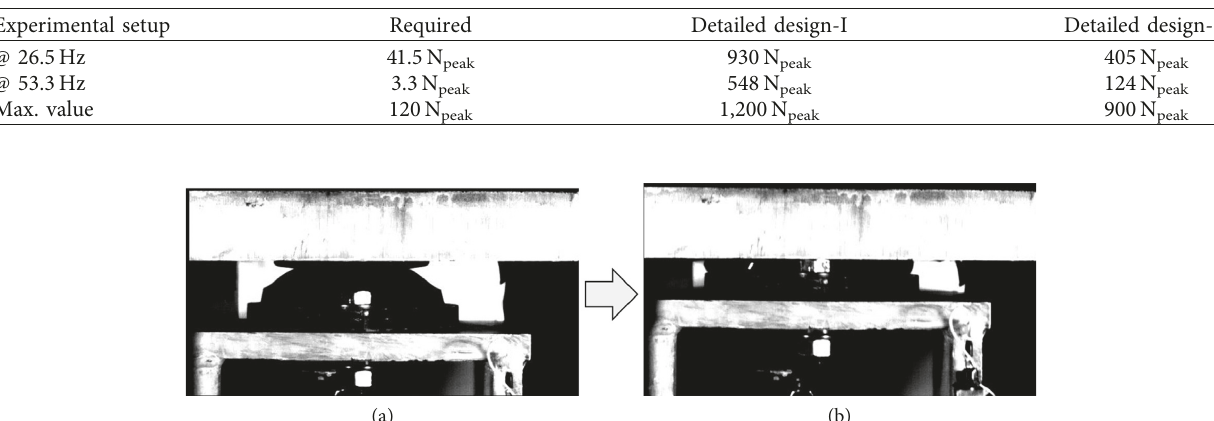
Table 5: Measurement results of blocking force compared with required force.